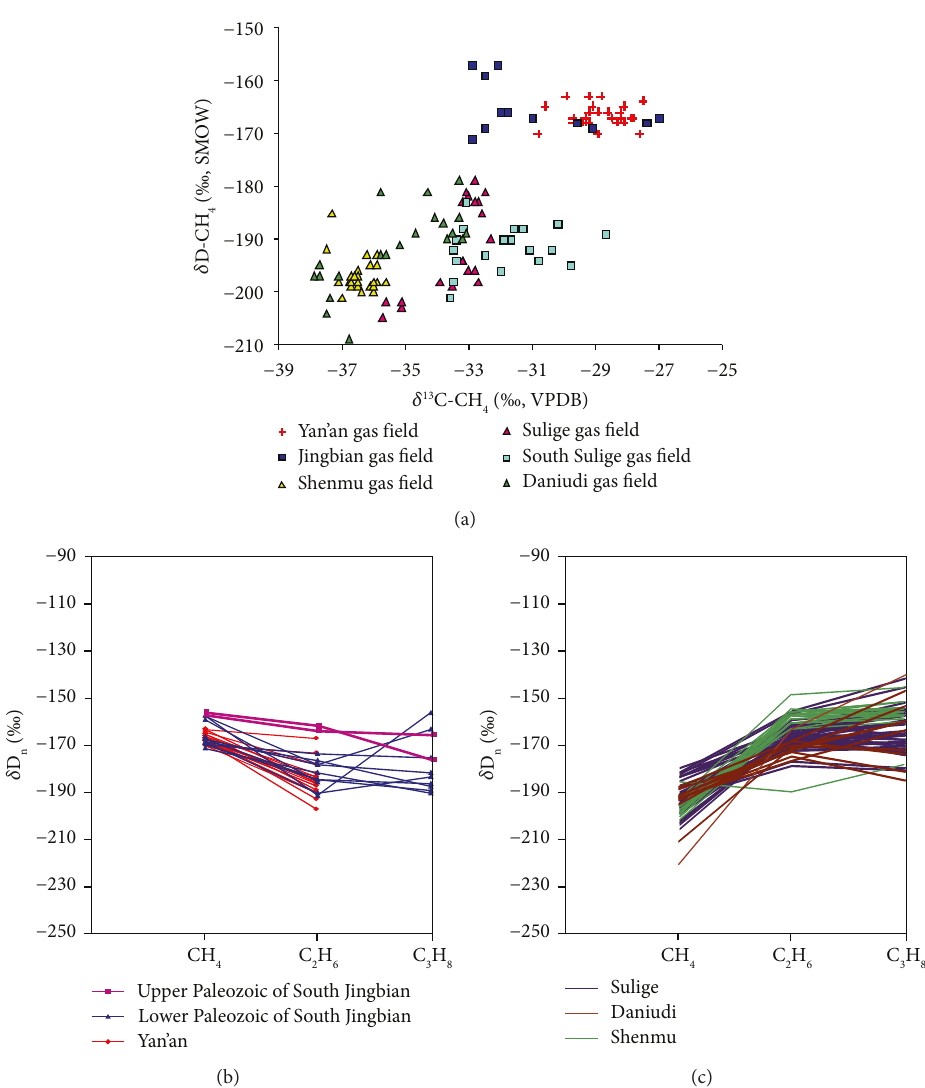
Figure 4: (a) Plot of δ D-CH and Yan ’ an gas fi elds (all gases show hydrogen isotopic reversal with δ D-CH Sulige, Daniudi, and Shenmu gas fi elds (with positive hydrogen isotopic